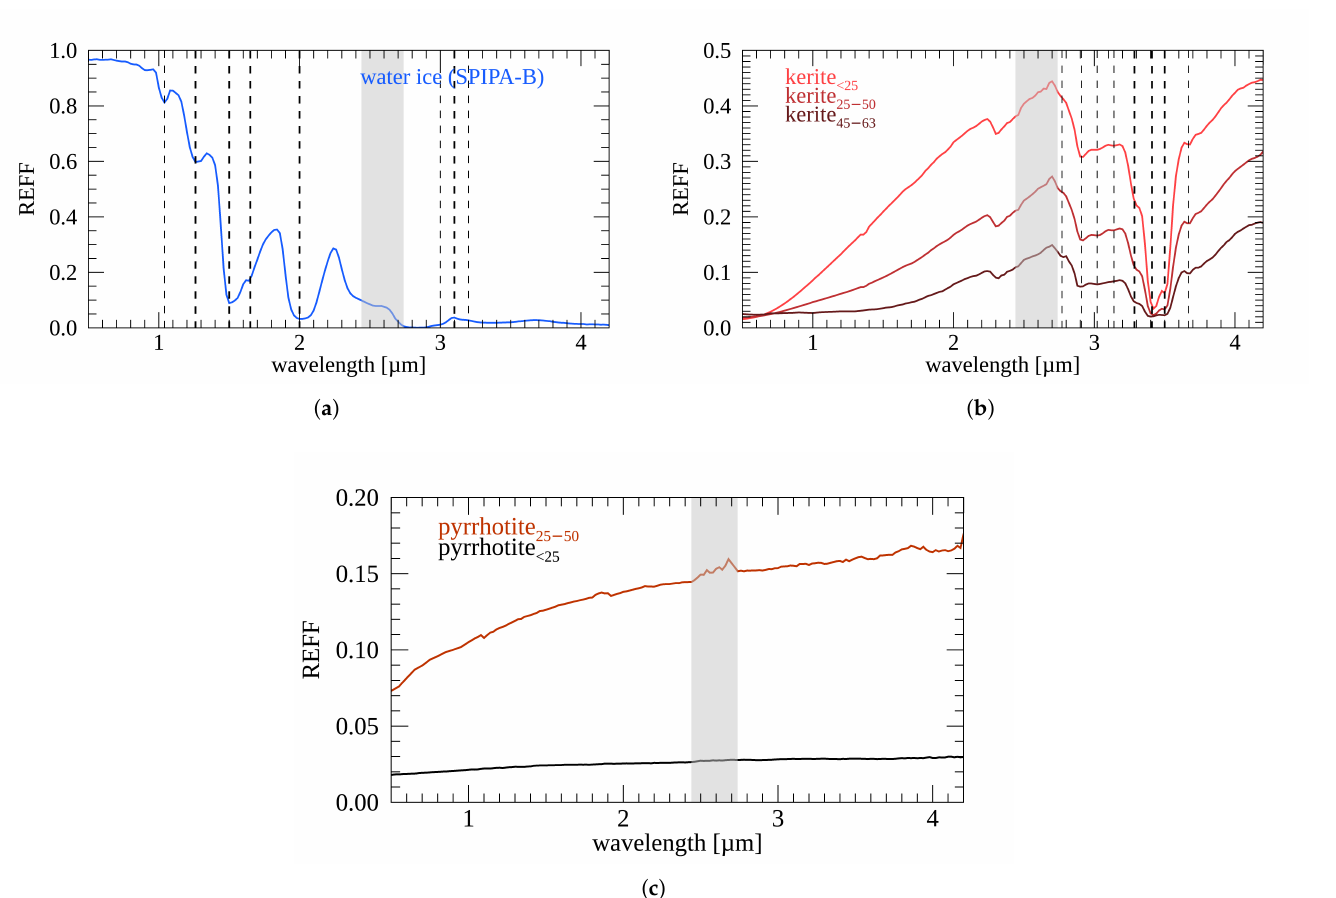
Figure 1. Reflectance spectra of water ice ( a ; SPIPA-B), kerite ( b ), and pyrrhotite ( c ) samples. Spectral features described in the text are indicated by dashed lines. The major spectral features of water ice and the kerite aromatic CH and CH 2 /CH 3 aliphatic/aromatic absorptions (contributing to the broad 3.18–3.64 µ m band) are indicated by bold dashed lines. These features, for the different sets of mixtures, are characterized by means of apposite spectral indicators in Section 3. The light gray bands indicate a spectral region where possible residual water vapour contamination in the optical path may affect the resulting